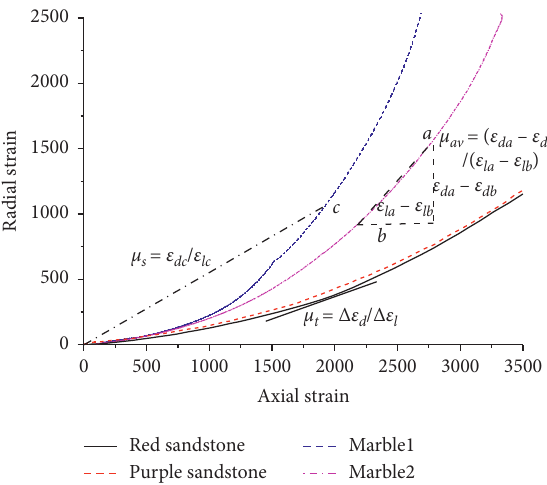
Figure 6: The equations for calculating μ